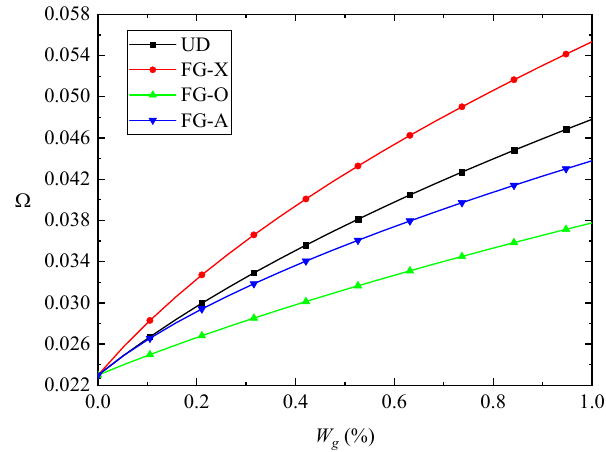
Figure 3. E ff ects of GPL weight fraction on the fundamental frequency of S-S FG-GPLRC circular arch ( θ 0 = π / 3, λ = 1 /